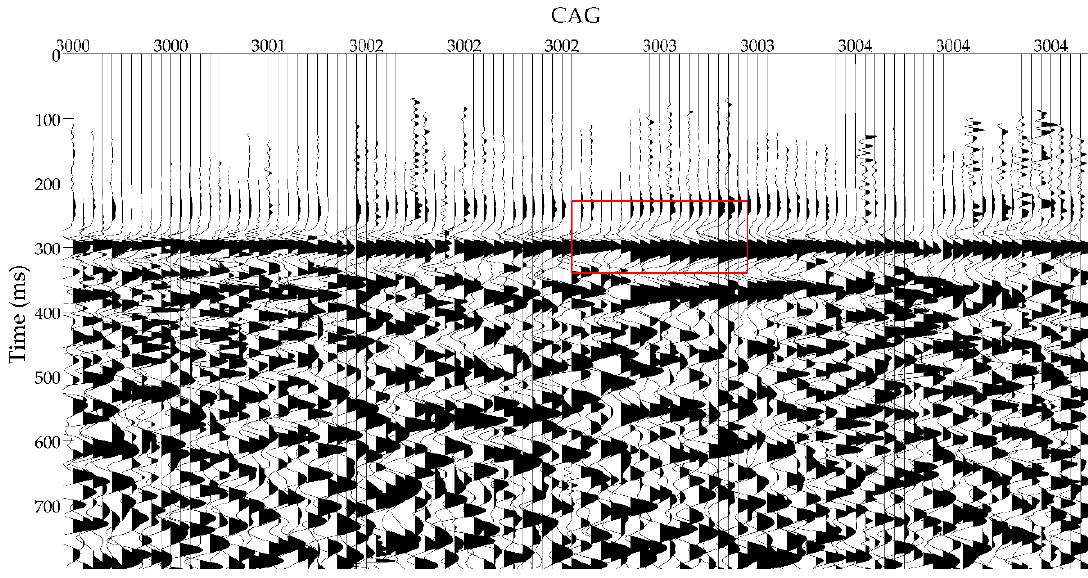
Figure 8. Shot gather (No. 624) after static correction based on common attitude gathers (CAGs).